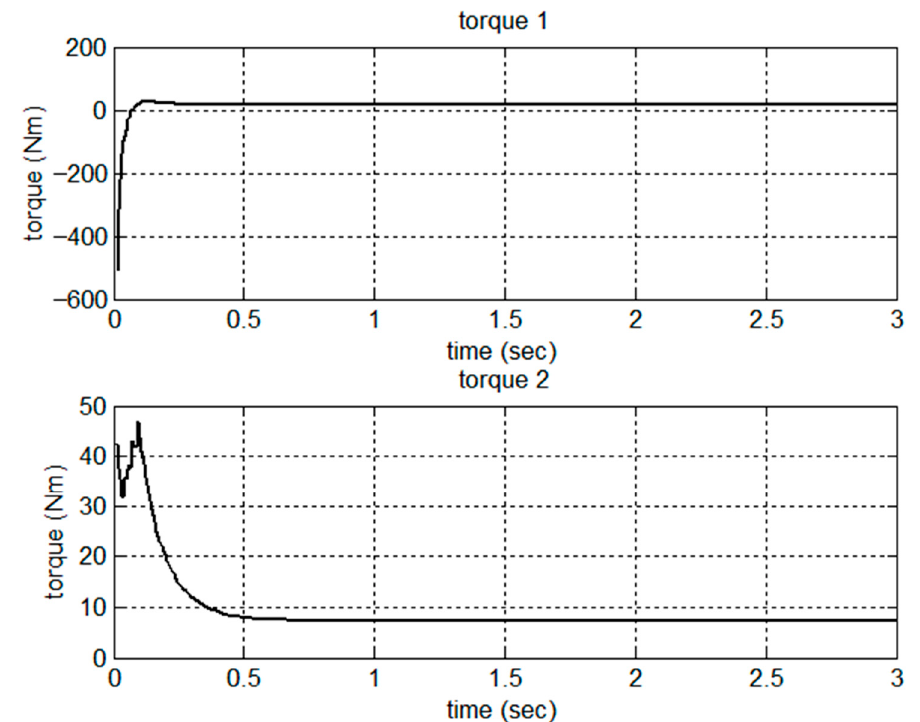
Figure 17. Control Figure 17. Control torques.